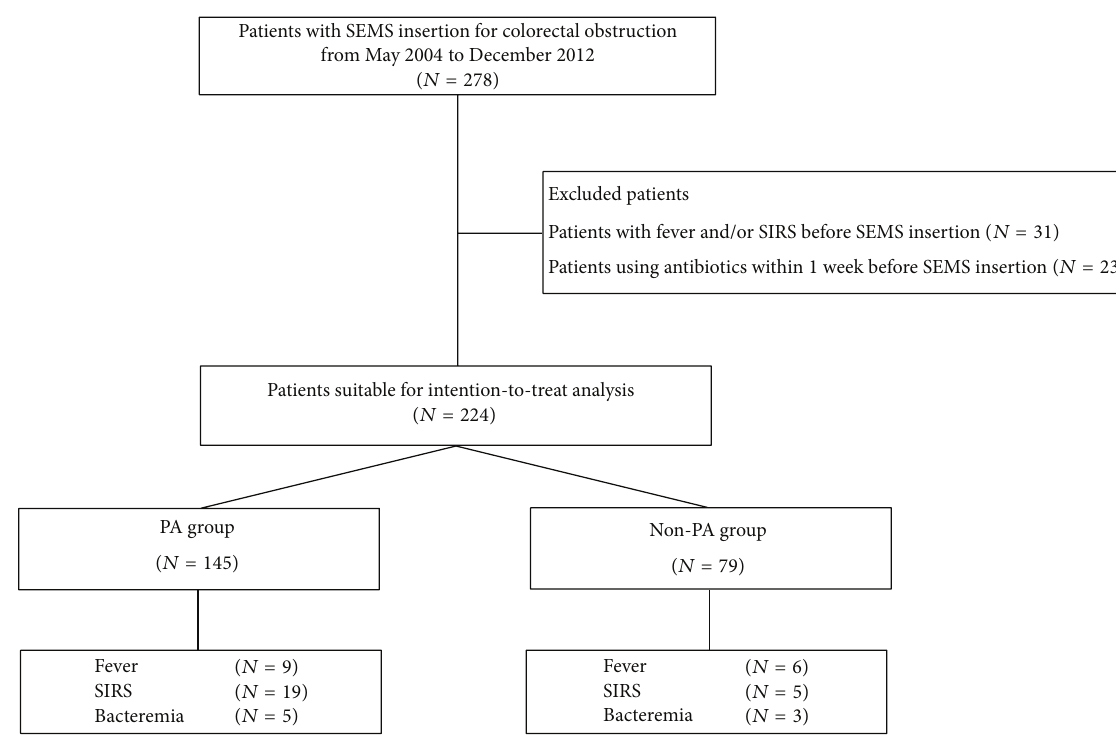
Figure 1: Flow chart showing patient selection of the allocation of malignant colorectal obstruction. SEMS, self-expandable metallic stent; 𝑁 , number; PA, prophylactic antibiotic; SIRS, systemic inflammatory response